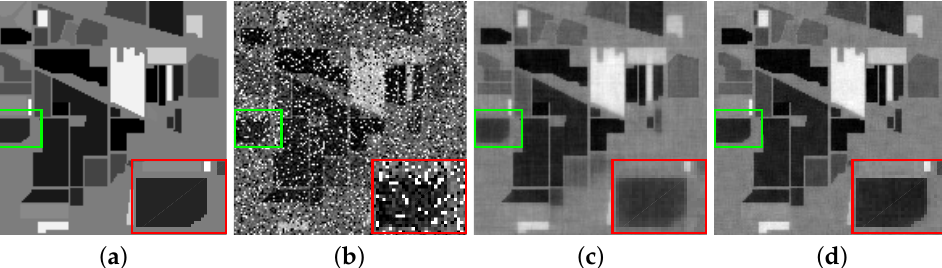
Figure 9. ( a ) Original image, ( b ) noisy image, image denoised by ( c ) 3DTNN, ( d ) ours of band 4 in the dataset-2, noise case 5.